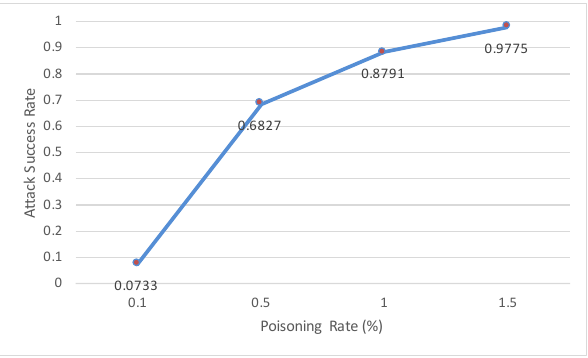
Figure 7. The poisoning rate evaluation of the